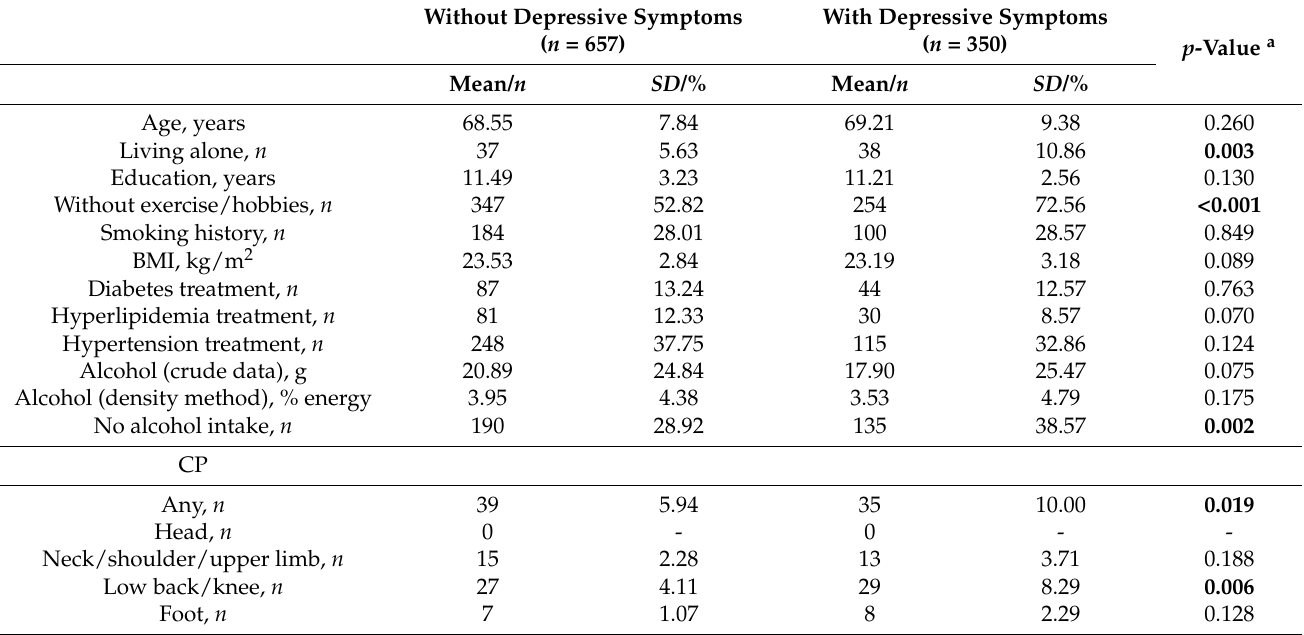
Table 2. Differences between the participants with and without depressive symptoms in